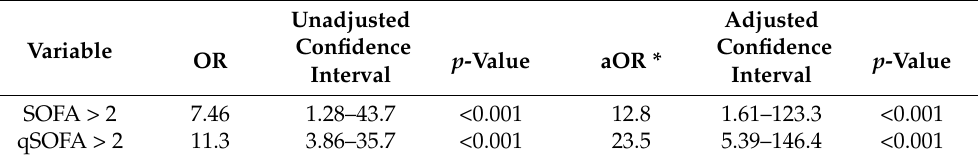
Table 5. In-hospital mortality odds ratio according to cut-off values of risk scores. Unadjusted Adjusted Confidence Confidence Variable p -Value p -Value aOR * OR Interval Interval SOFA > 2 7.46 1.28–43.7 <0.001 12.8 1.61–123.3 <0.001 qSOFA > 2 11.3 3.86–35.7 <0.001 23.5 5.39–146.4